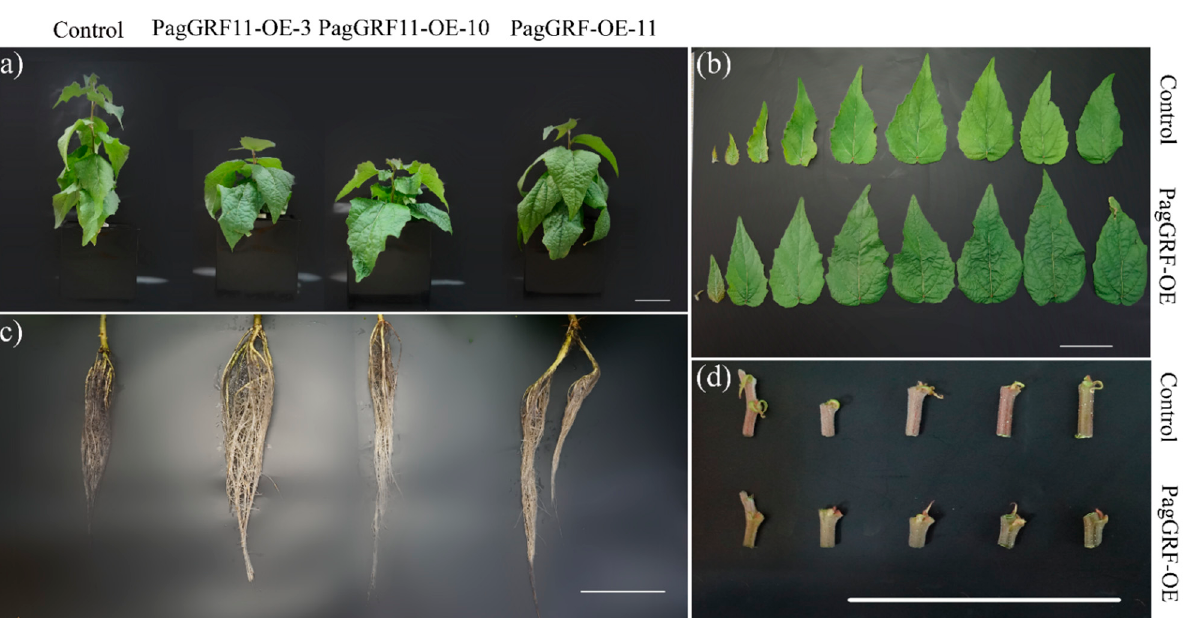
Figure 2. Morphological characterization of Pag-GRF11 -overexpressing transgenic plants. ( a – d ) General characteristics of 3-month-old plants overexpressing PagGRF11 and control. Control: “84K” populus carried the pBI121 empty vector (scale bar = 5 cm). ( a ) Plant height, ( b ) leaf, ( c ) root, and ( d ) stem internode of control and PagGRF11 transgenic plants. ( e ) Three-month-old plants were used to measure stem dry weight, stem fresh weight, plant height, third internode diameter, root